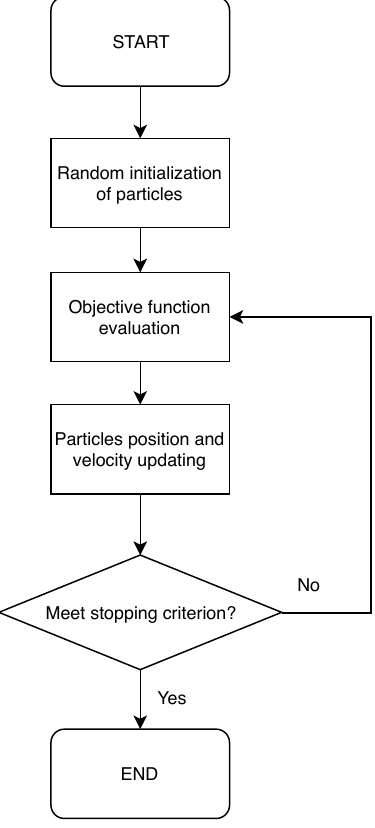
Figure 2. PSO: flow chart.